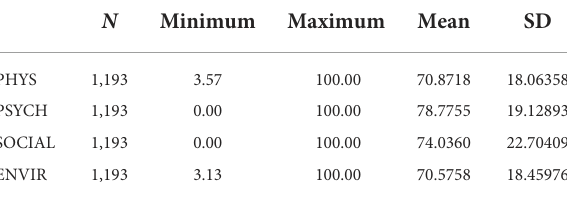
TABLE 10 Descriptive statistical analysis of quality of life, on the whole sample, according to the four major areas. N